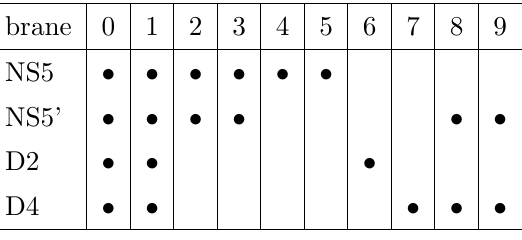
Table 1 . Type IIA brane con(cid:12)guration for U( k